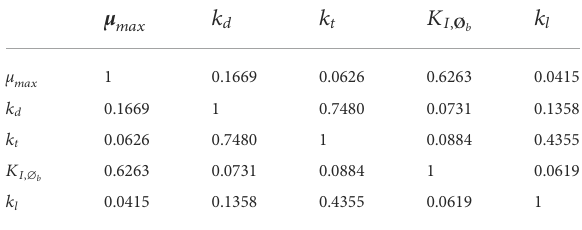
TABLE 2 Correlation matrix (absolute value) of the parameters identi fi ed on the whole set of